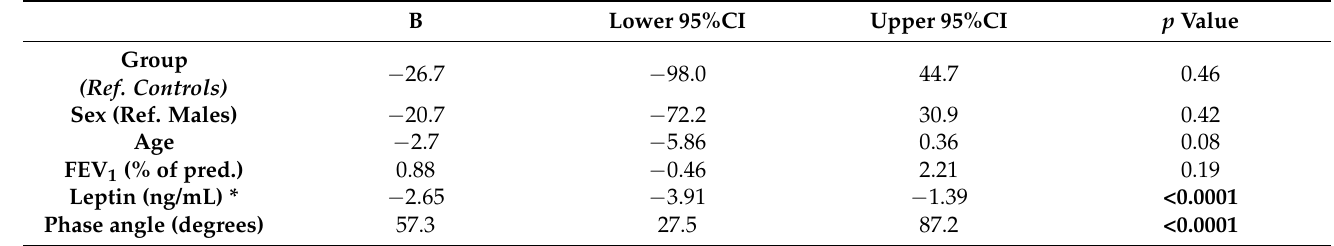
Table 3. Multiple linear regression model for 6 min walking test. R 2 =